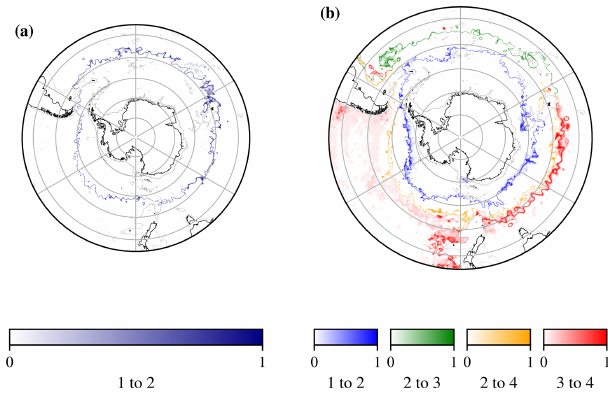
Figure 7. Decreasing K removes details from the statistical descrip- tion of Southern Ocean thermohaline structure. Shown is the GMM- derived I -metric, using (a) K = 2 and (b) K = 4, for a monthly average over June 2011. The grey line is 2000m